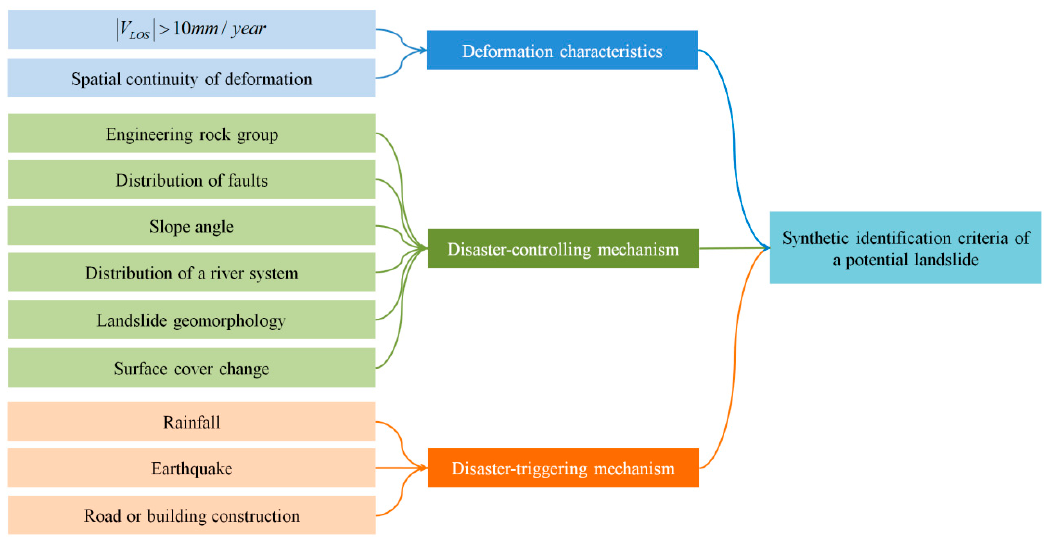
Figure 3. Synthetic criteria for potential landslide